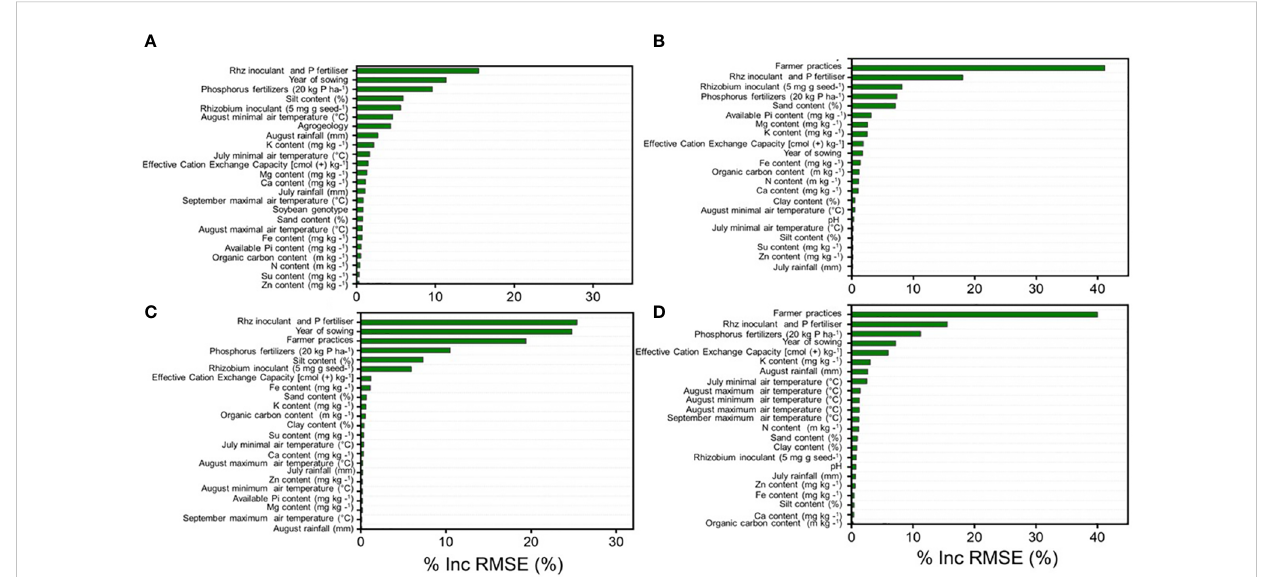
FIGURE 5 Best inputs variable of importance from soil, weather, and factorial estimators used to predict soybean yields from all sample sets (A) , Sudan (B) , Northern Guinea (C) , and Southern Guinea (D) Savannas of